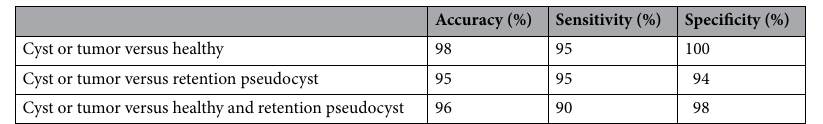
Table 3. Performance of the model for guidance regarding additional imaging or